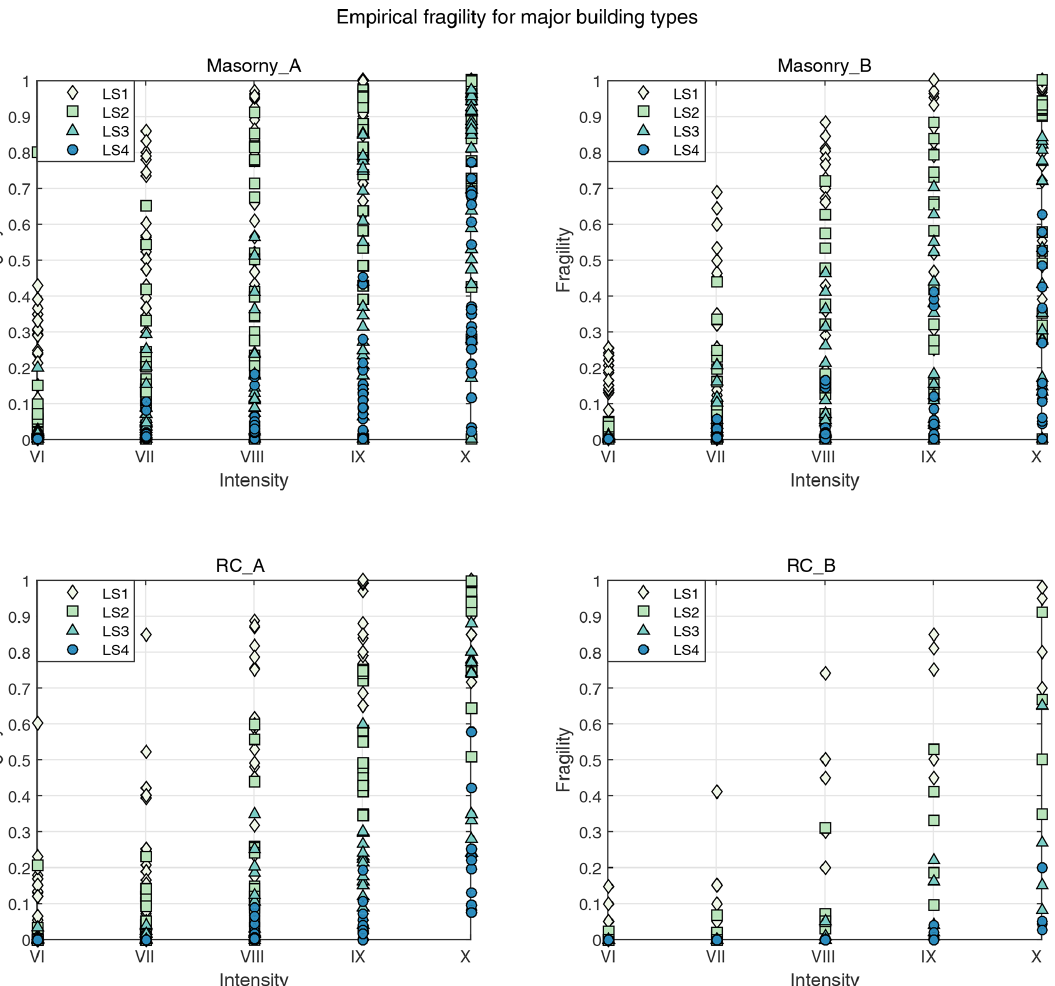
Figure 3. The distribution of empirical fragility data from post-earthquake field surveys, depicting the relation between the exceedance probability of each damage limit state (LS1, LS2, LS3, LS4) at given macroseismic intensity levels. The fragility datasets are grouped by building types (masonry and RC) and seismic resistance levels (A and